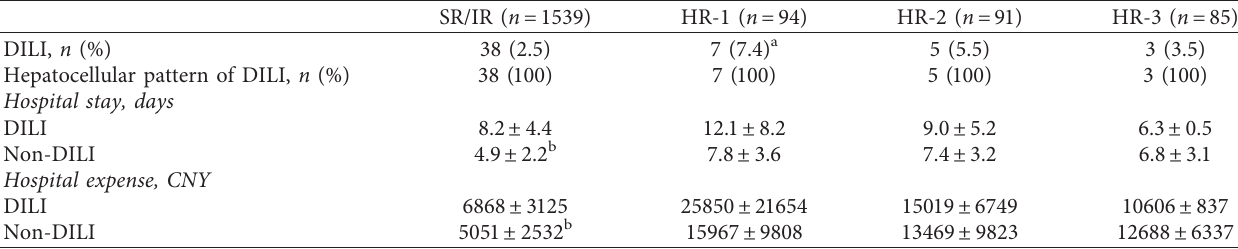
Table 2: Characteristics of DILI in different regimens.